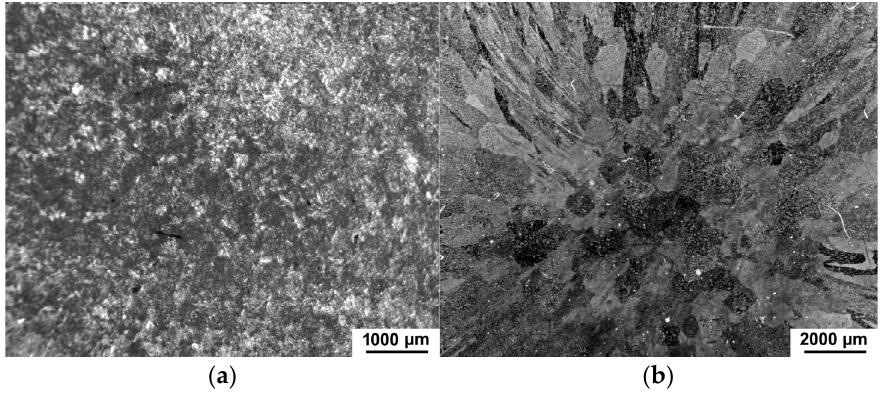
Figure 3. The macrostructures of the as-cast composites: ( a ) AlMgGr and ( b ) AlMnGr.